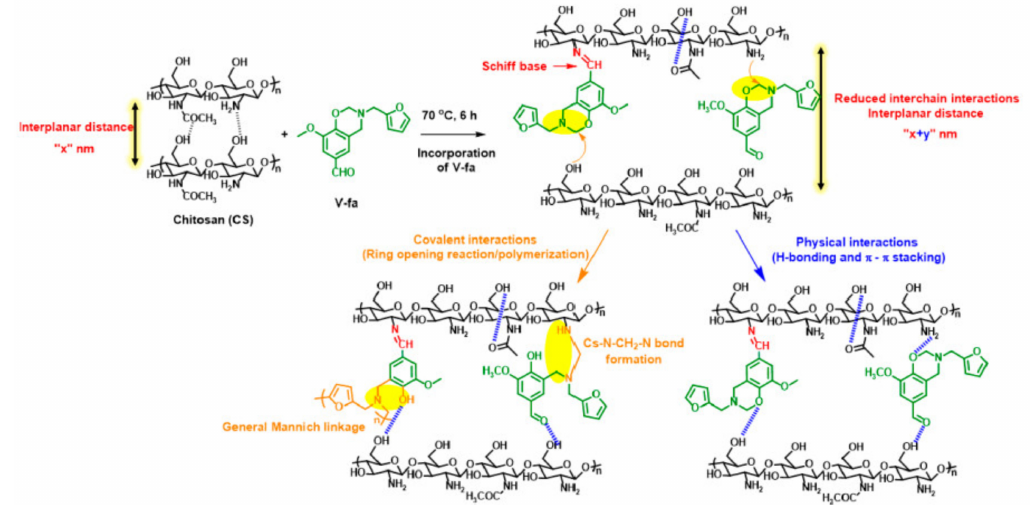
Figure 58. Mechanistic representation of interaction of V-fa with CS with the formation of covalent and physical link- ages [361]. Copyright 2019. Reproduced with permission from American Chemical